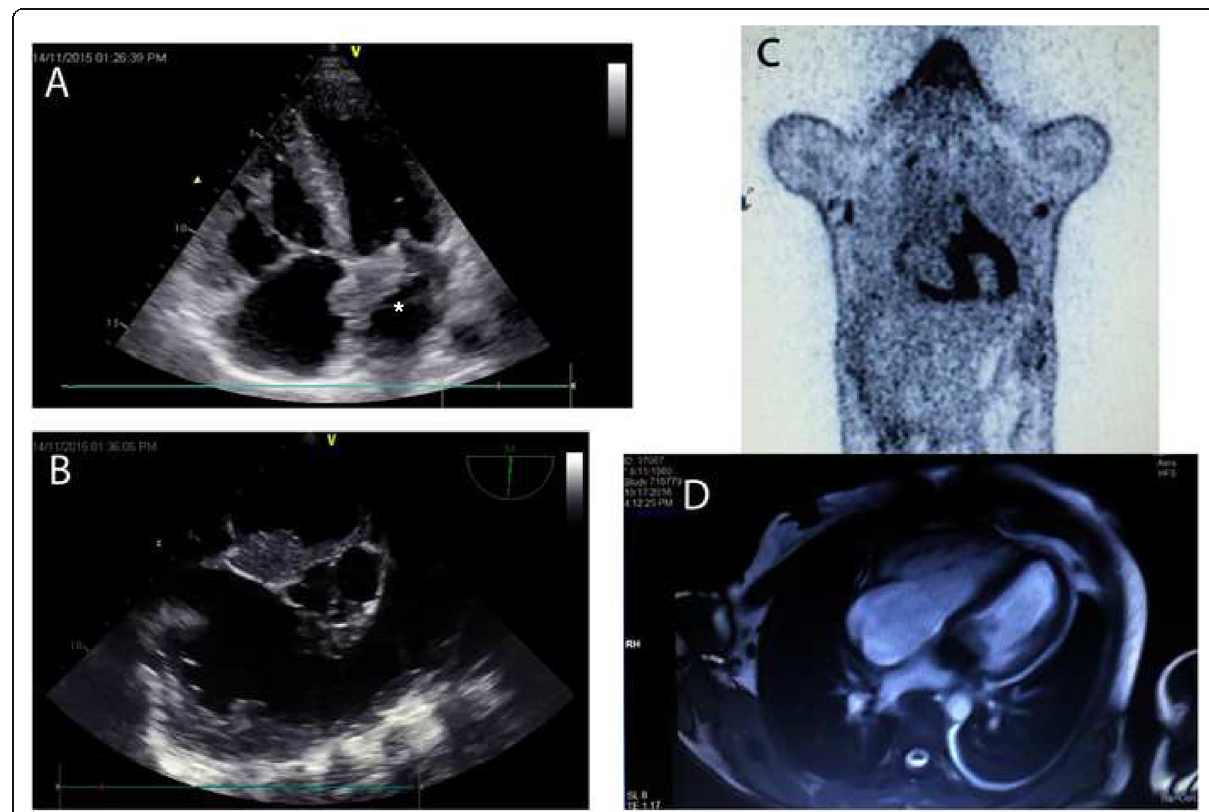
Fig. 1 Cardiac hemangioendothelioma. a and b Transesophageal echocardiography images showing the mass infiltrating the IAS and the aortomitral continuity. c PET CT scan showing the recurrence of the resected mass along with multiple pleural deposits. d Cardiac MRI showing